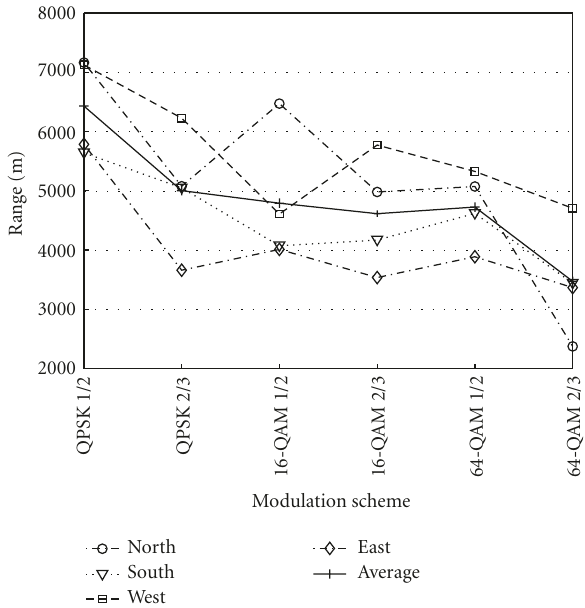
Figure 4: Range R for the di ff erent modulation schemes and for di ff erent